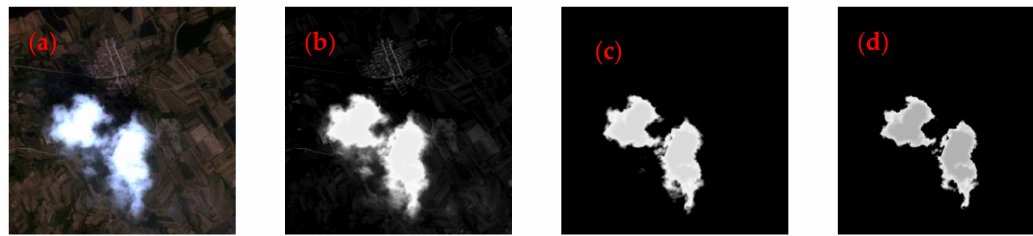
Figure 6. The feature map from the different pooling models. ( a ) Original image; ( b ) the feature map obtained from the self-adaptive pooling (SAP) model; ( c ) the feature map obtained from the average pooling model; ( d ) the feature map obtained from the max pooling model.